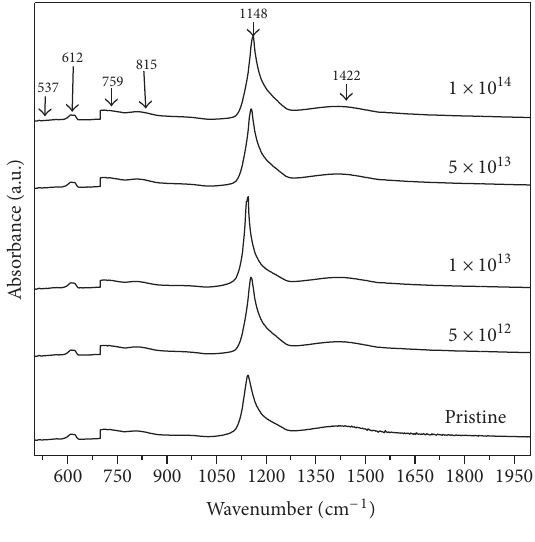
F 12: Showing the FTIR spectra of Li BBiSB